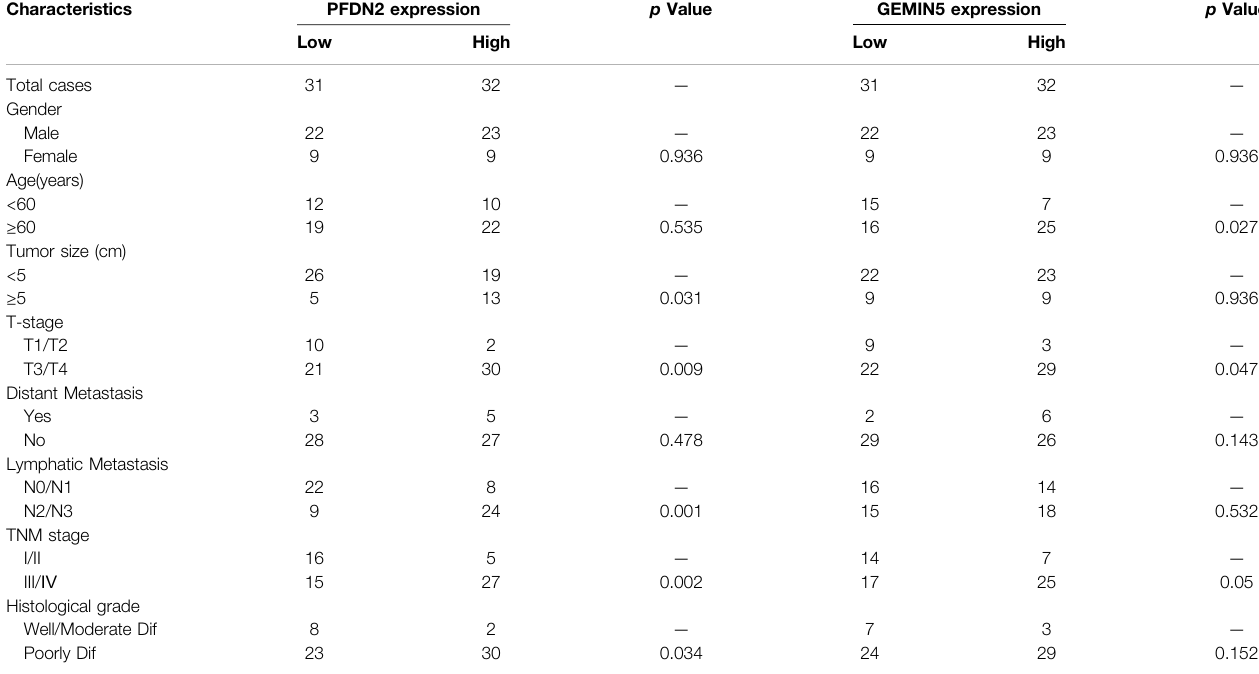
TABLE 2 | clinicopathological features and expression of PFDN2 and GEMIN5